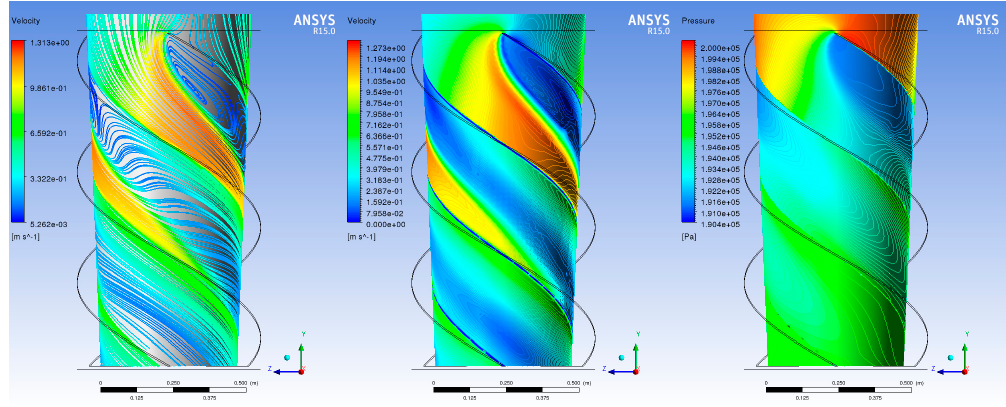
Figure 13. NC conditions: zoom on the frusto-conical diverging part.